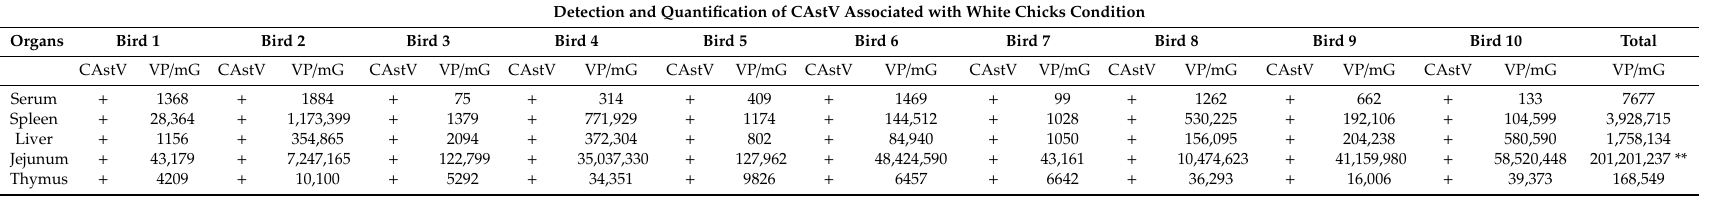
Table 2. Detection and absolute quantification of CAstV associated with WCS in the serum, spleen, liver, jejunum, and thymus. Detection and Quantification of CAstV Associated with White Chicks Condition